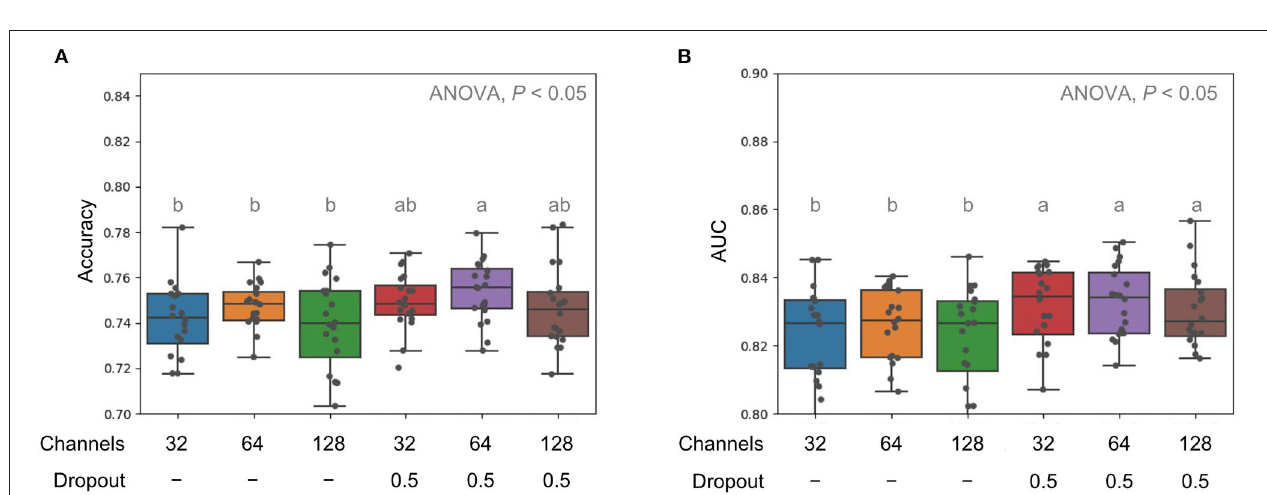
FIGURE 2 | Comparison of average pooling in terms of accuracy (A) and AUC (B) for input mass spectrometry (MS) raw data and rectified linear units (ReLu) as activation function. Multiple comparison tests on the different units were applied in the models using one-way ANOVA, following the post-hoc Tukey honest significant difference (HSD) test for paired difference with a p -value < 0.05. Different letters indicate a significant difference.